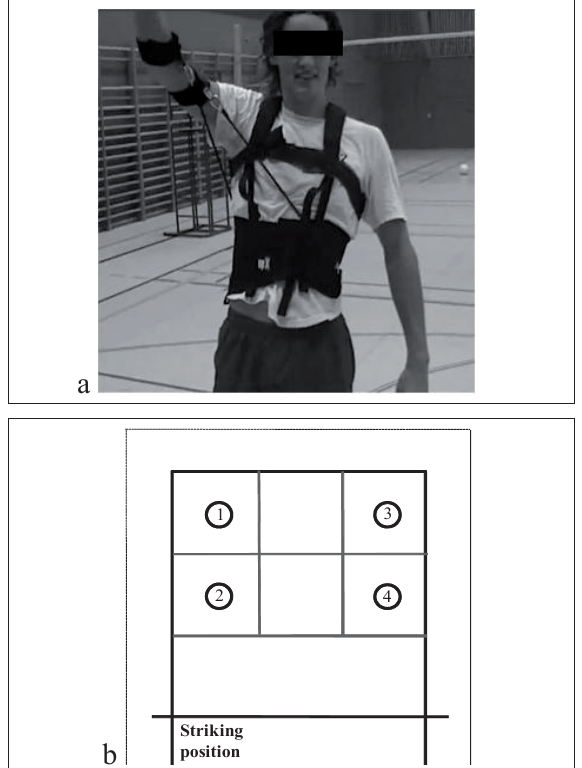
Figure 1 a. Application of the elastic cords